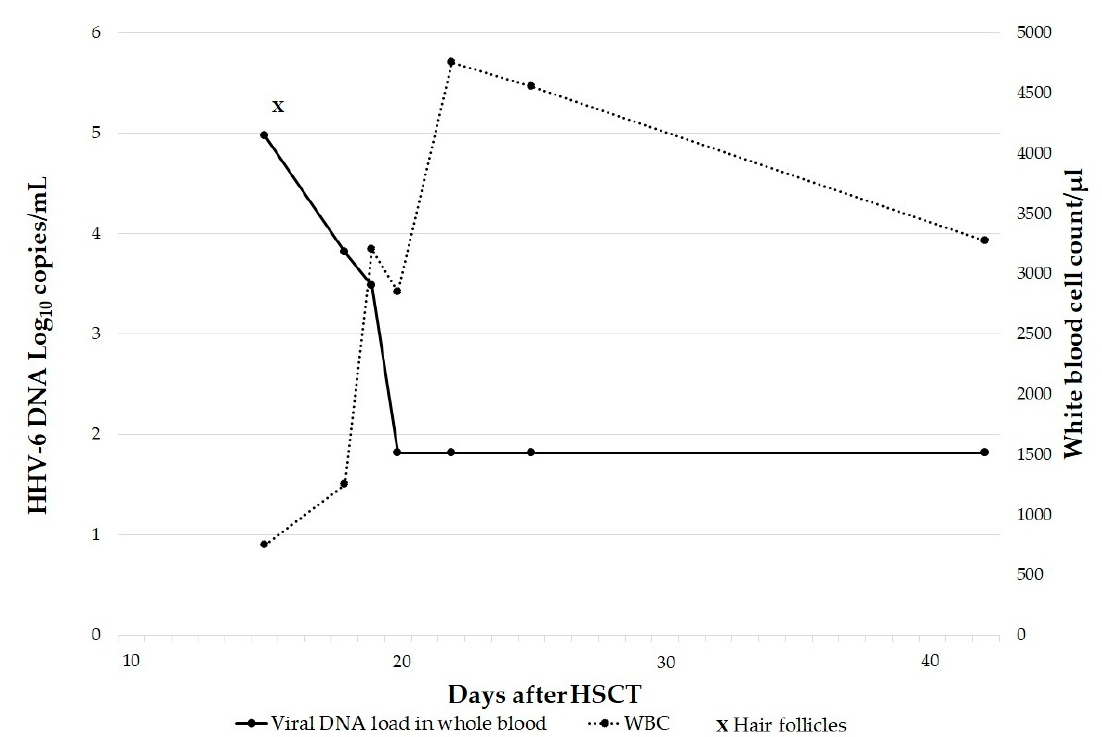
Figure 1. Monitoring of blood HHV-6 DNA post-hematopoietic stem cell transplantation (HSCT) in a patient with iciHHV-6 who received a graft from a donor without iciHHV-6. HHV-6 DNA was related to white blood cell (WBC) count in the early period after transplantation. Table 2. Overview of the 37 iciHHV-6 adult patients: clinical features leading to HHV-6 investigation, HHV-6 DNA load in CSF and WB and patients’